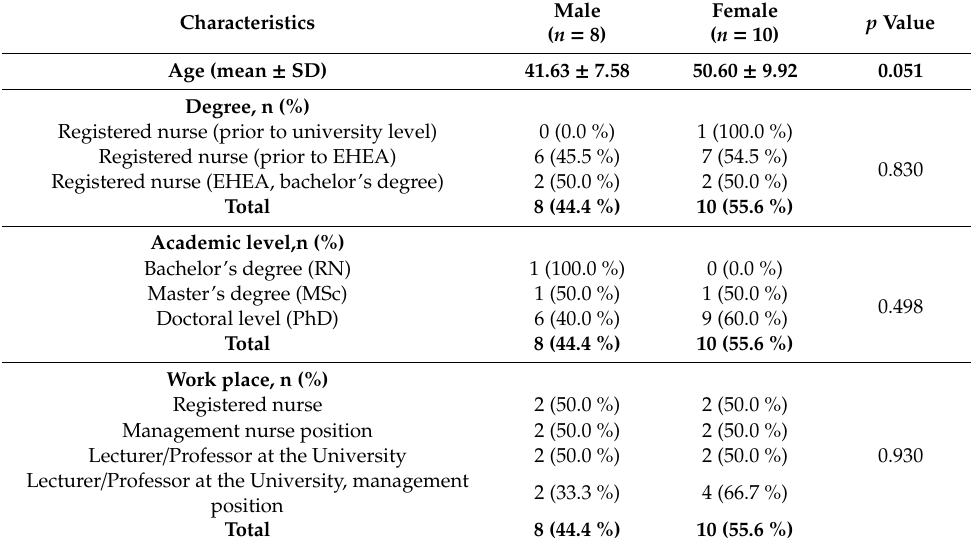
Table 1. Characteristics of the study sample